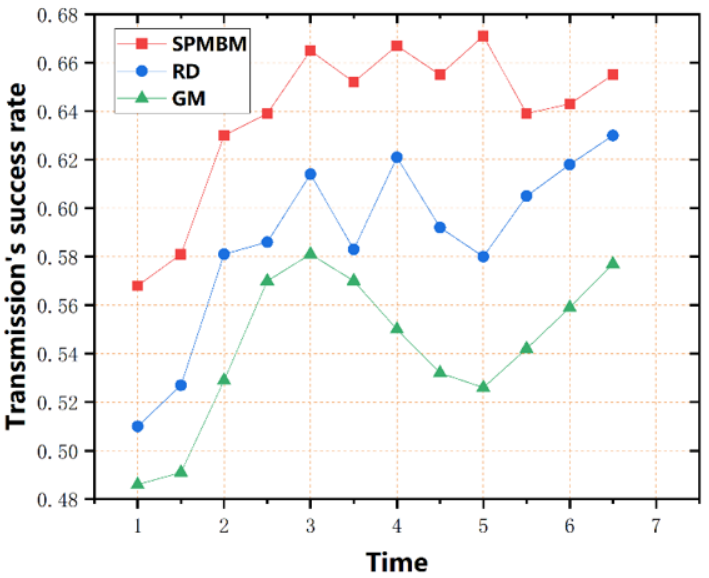
Figure 8. Relationship between transmission success ratio and time in three mobility models.